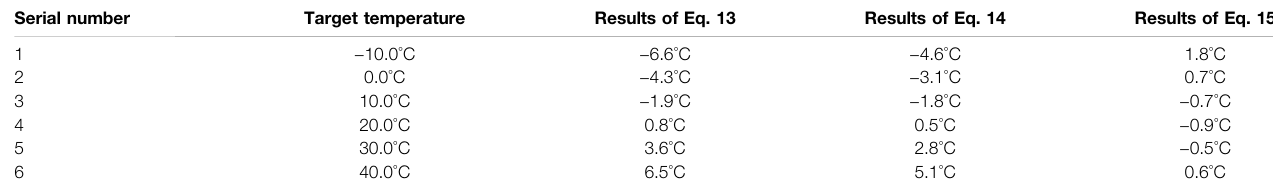
TABLE 2 | Veri fi cation experiment when environmental temperature equal to target temperature. Serial number Target temperature Results of Eq. 13 Results of Eq. 14 Results of Eq.